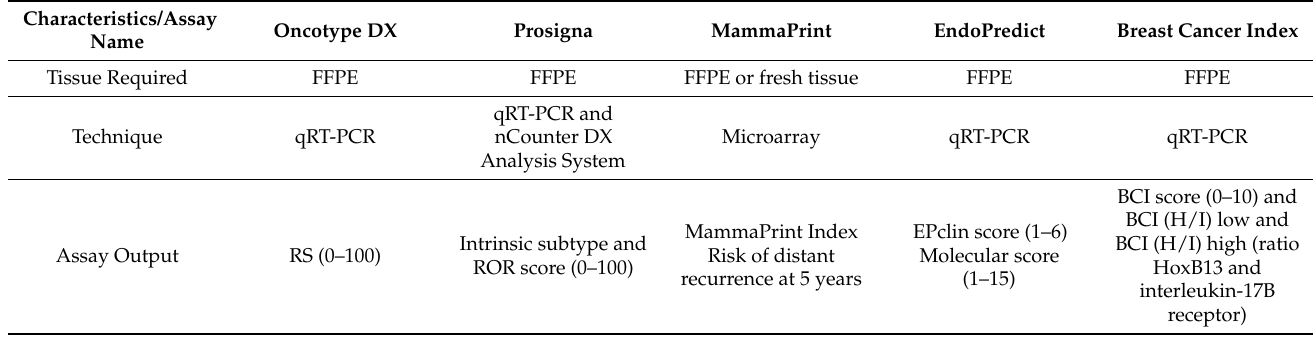
Table 3. Summary of assay